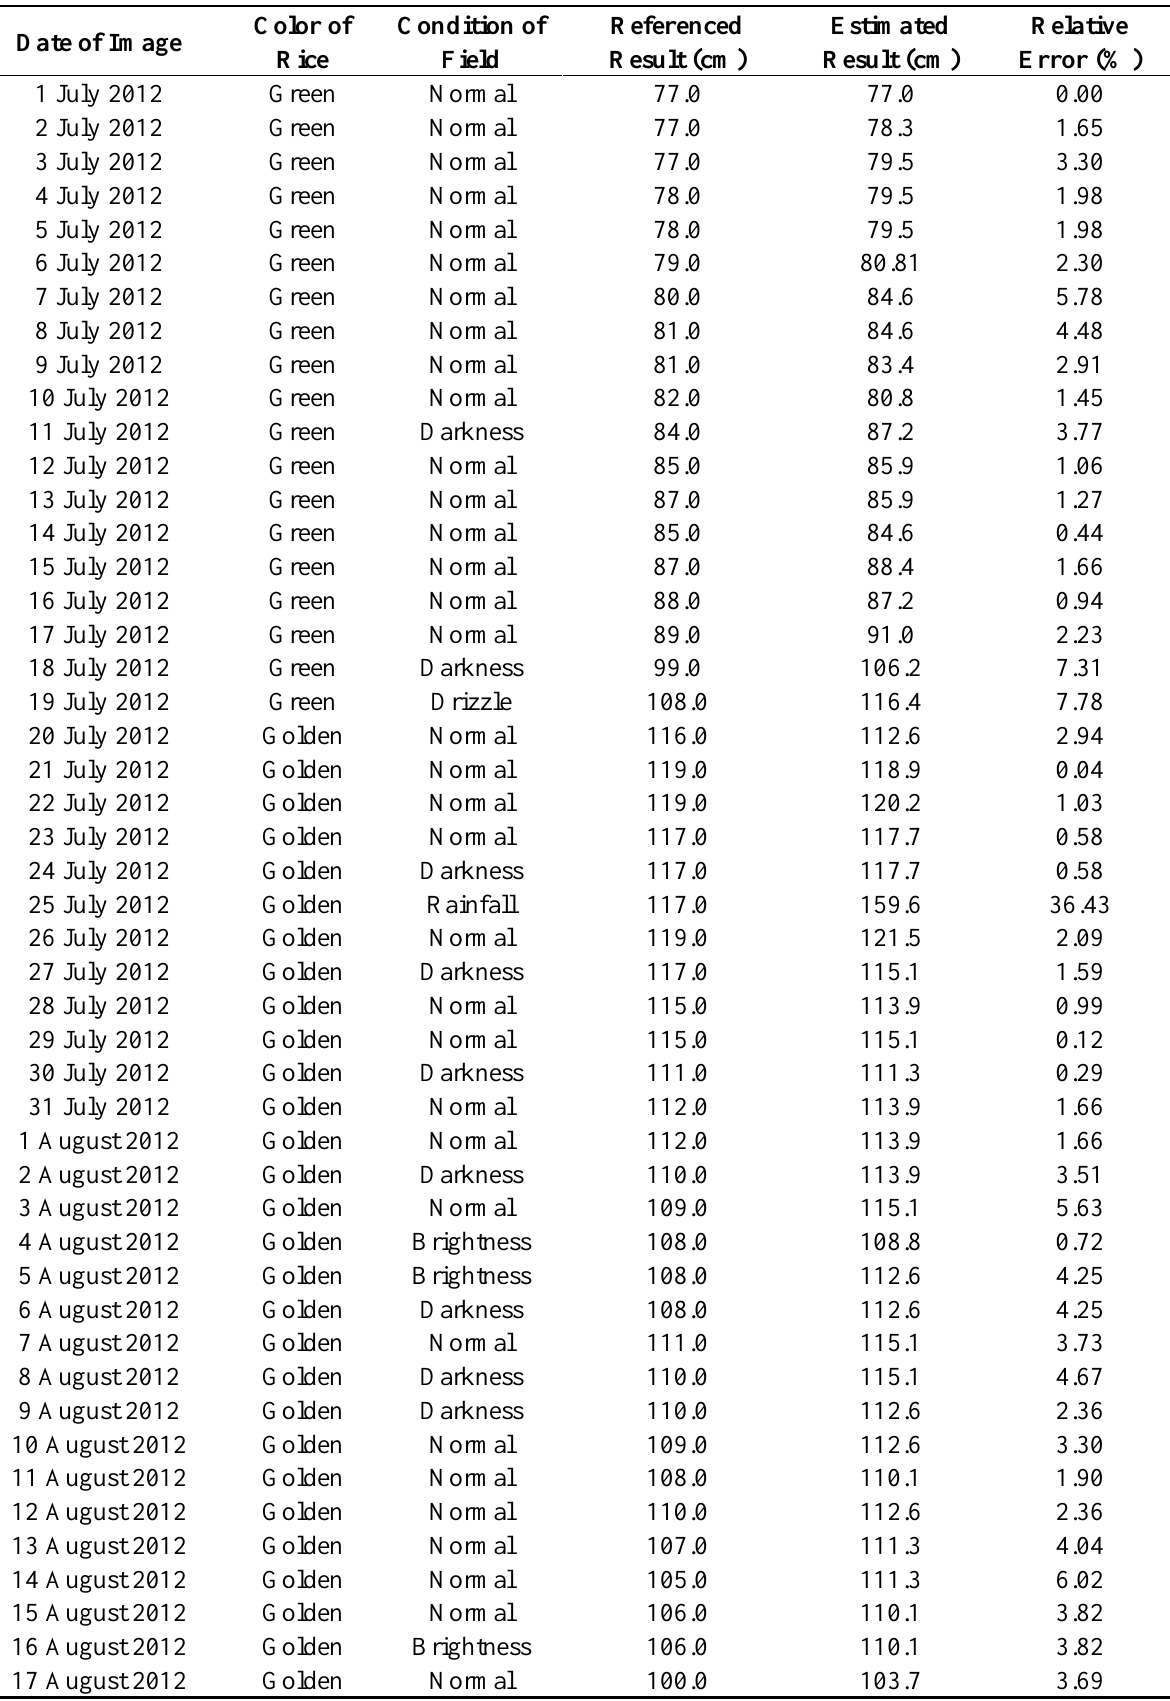
Table 2. Comparison between estimated results using excess green feature and referenced